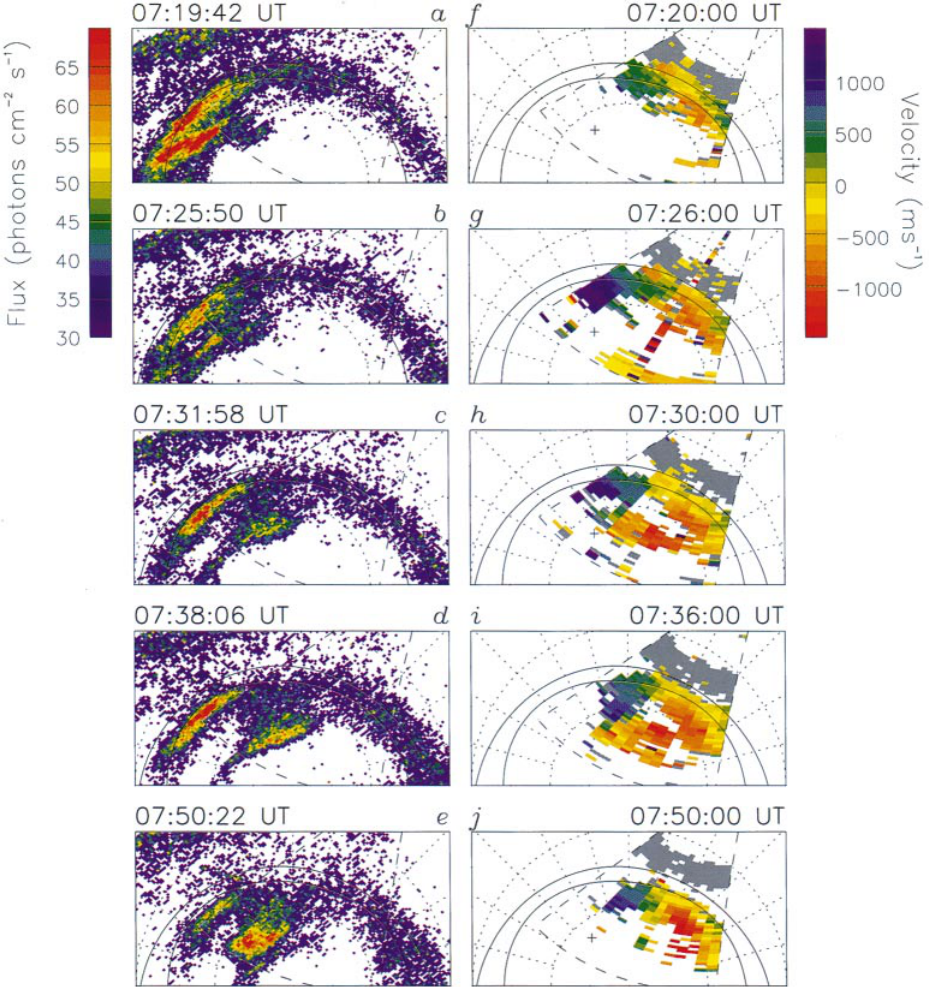
Fig. 5. a – e Polar UVI images of the dayside Northern Hemi- sphere, in magnetic latitude and MLT coordinates, in the same format as Fig. 2, from selected times for comparison with radar observations. Superimposed is a statistical auroral oval and the location of the radar field-of- view. f – j Line-of-sight velocity maps from CUTLASS Finland radar scans corresponding to the Polar UVI images in a –